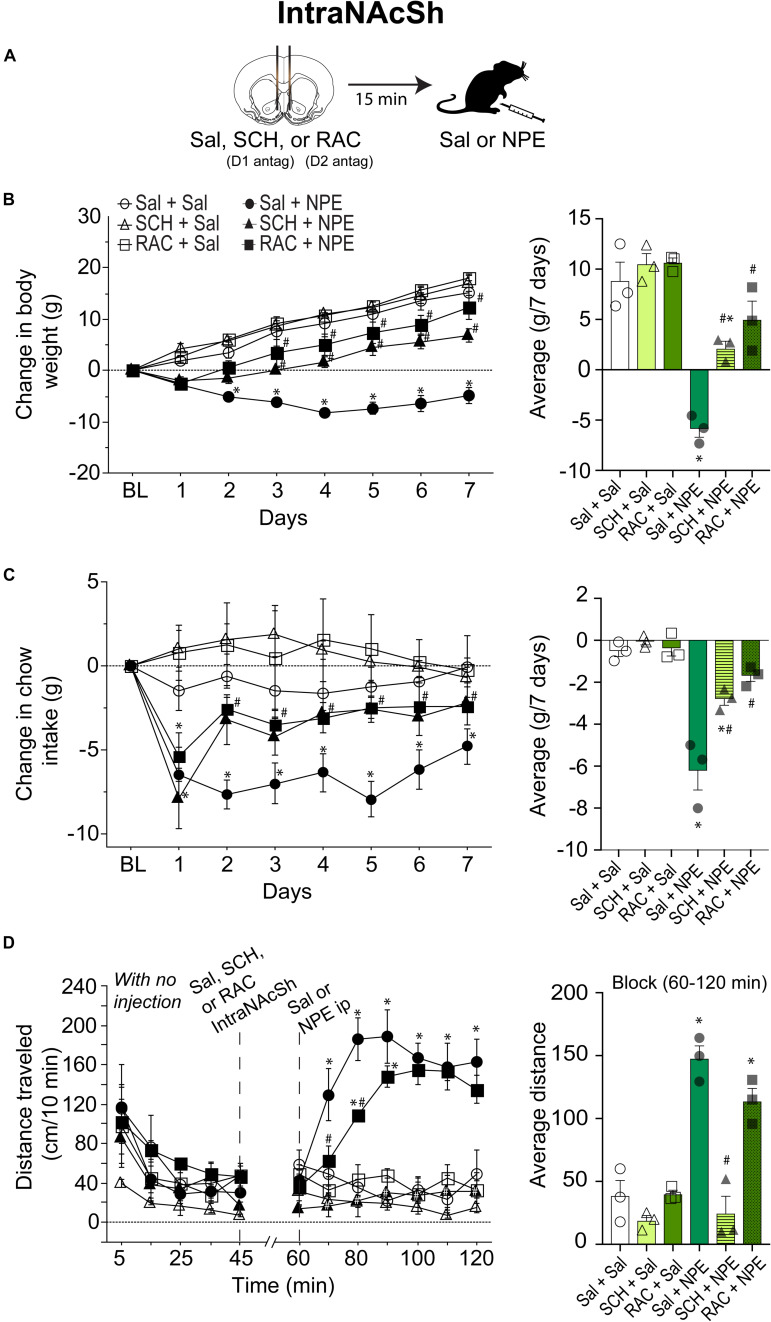
Role of intra-NAcSh dopamine D1- or D2-like receptors on NPE’s induced behavioral effects. (A) The protocol of drug administration: intra-NAcSh injection either Sal, or RAC, or SCH (at 45 min), followed by i.p. injection of either Sal or NPE (at 60 min, see panel D). (B)
Left panel: Change in body weight during 7 consecutive days of treatment. Right panel averaged over 7 days. (C)
Left panel: Change in chow intake (g) relative to BL. Right panel: The average change in chow intake. (D)
Left panel: The distance traveled (cm/10 min) on a period with no injection (interval 0-45 min) and after injections (60–120 min). Right panel: Average distance. ∗p < 0.05 significantly different than in Sal + Sal. #p < 0.05 compared to Sal + NPE group.